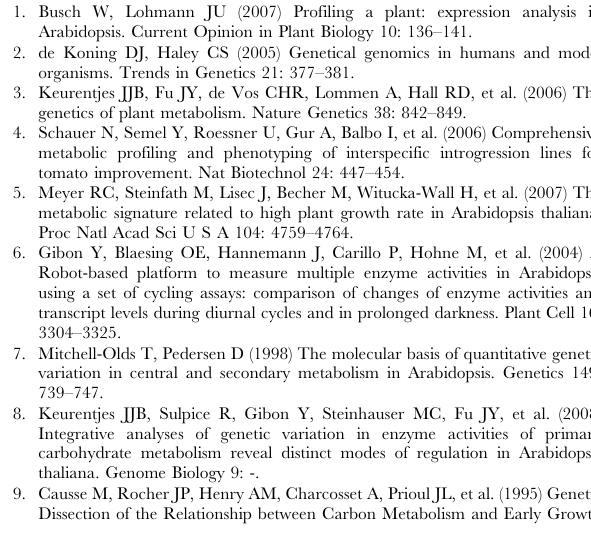
Figure S1 IDH activity at two incubation temperatures across 100 maize inbred-lines. (A) Correlation between IDH activity at 25 u C and 35 u C. Each point represents the mean of five replications from each inbred line. Parallel to the X and Y axes are the frequency distribution of the activity measurements. (B) Two way ANOVA for IDH activity against line and incubation temperature. Found at: doi:10.1371/journal.pone.0009991.s002 (0.12 MB TIF) Figure S2 Selected CCM enzymes and their pathway